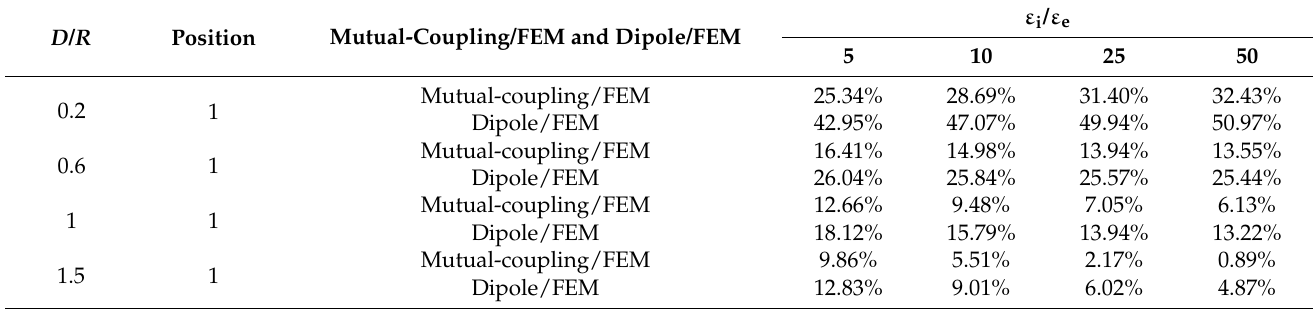
Table 2. The relative errors of the three models at position 1 (mutual-coupling/FEM and